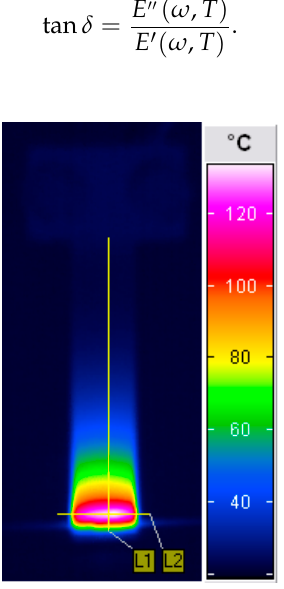
Figure 2. Typical self-heating temperature surface distribution in cantilever mode loading.